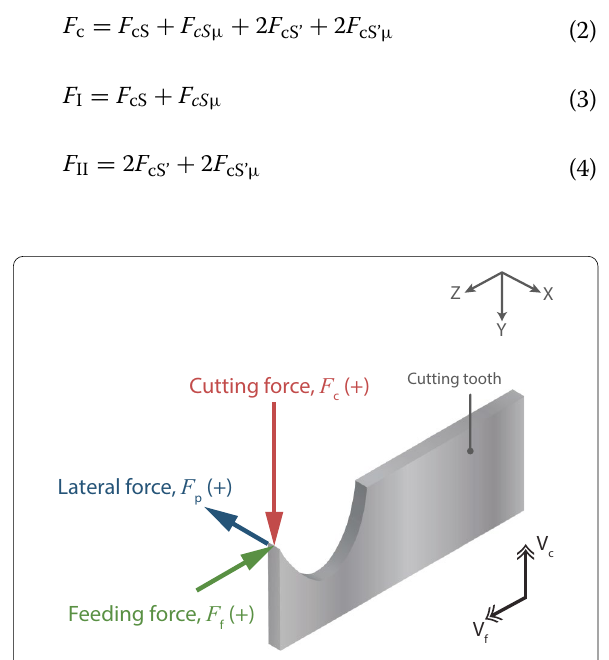
Fig. 3 The three principal forces acting on a saw